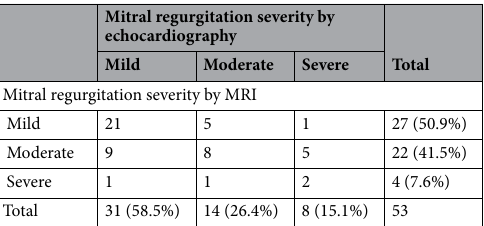
Table 2. Comparison between echocardiography-derived and MRI-derived mitral regurgitation grades.